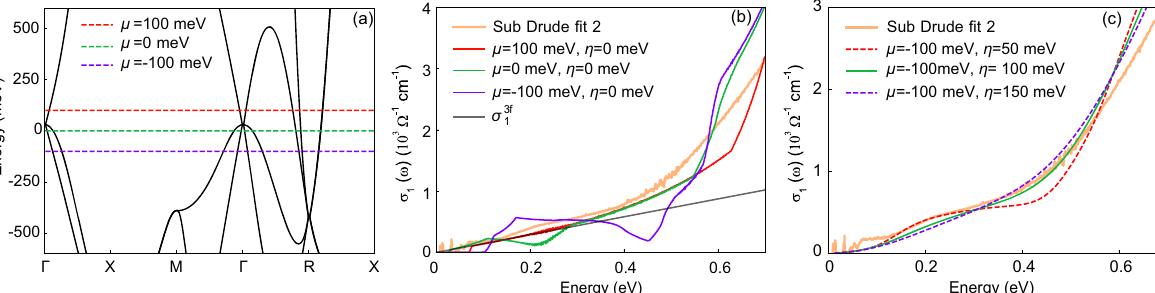
Fig. 4 Four-band model. a Band structure obtained using a tight-binding model for RhSi without spin – orbit coupling. b Optical conductivity conductivity by low-energy linear model is shown as a solid of RhSi for different chemical potentials μ without disorder broadening. The σ 3f 1 gray line. c Optical conductivity of RhSi calculated with different disorder-related broadenings, η , for μ = − 100 meV (see b ) using Eq. (4). The solid green curve has the same parameters ( μ = − 100 meV, η = 100 meV) as the tight-binding CPGE calculation (orange curve in Fig. 6c). in Fig. 2d the σ 1 ( ω ) spectra, after subtracting the two Drude response and the sharp phonon modes. With the subtraction of two Drude peaks with transport scattering rates of 200 and 2400 cm − 1 (Drude fi t 1 in Fig. 2d), we reveal a quasi-linear behavior